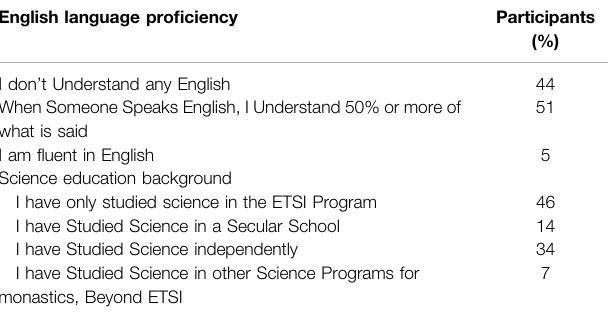
TABLE 1 | English language pro fi ciency and science education background amongmonastic studentstakingEmory-TibetScienceInitiative(ETSI)science classes in summer 2018 ( n (cid:1) 214).